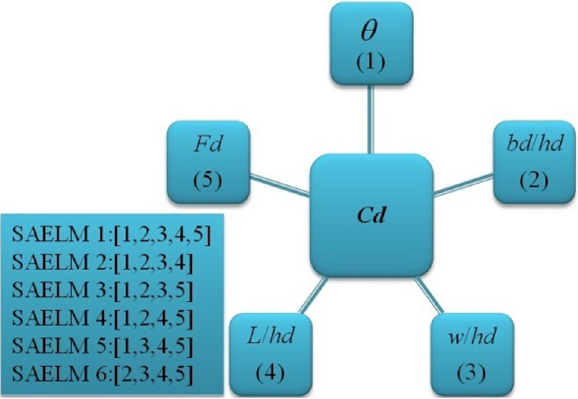
Fig. 2 Combinations of input parameters for self-adaptive extreme learning machine